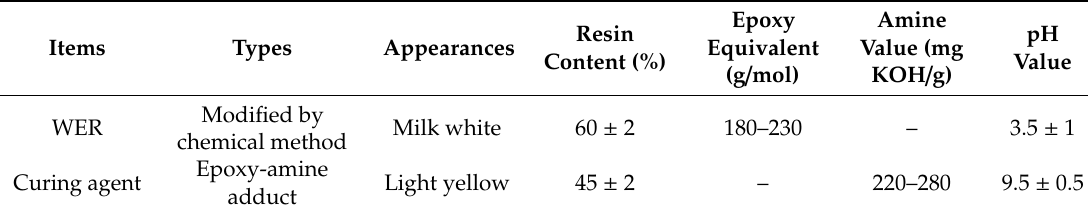
Table 2. Technical indicators of the waterborne epoxy resin (WER) and the corresponding curing agent (provided by the